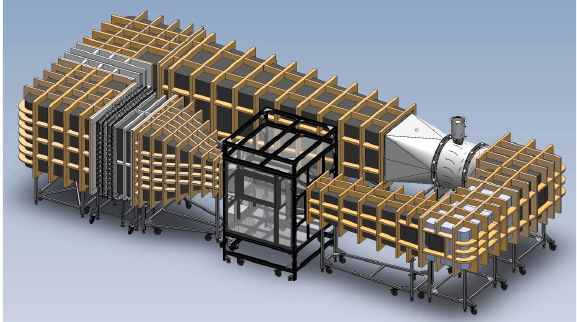
Fig. 1. Visualization of the wind tunnel.